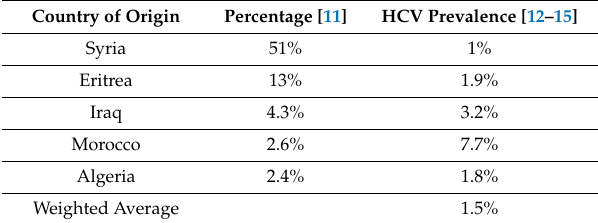
Table 2. Country of origin with corresponding percentage of total recently arrived migrants in the Netherlands in 2017 and HCV